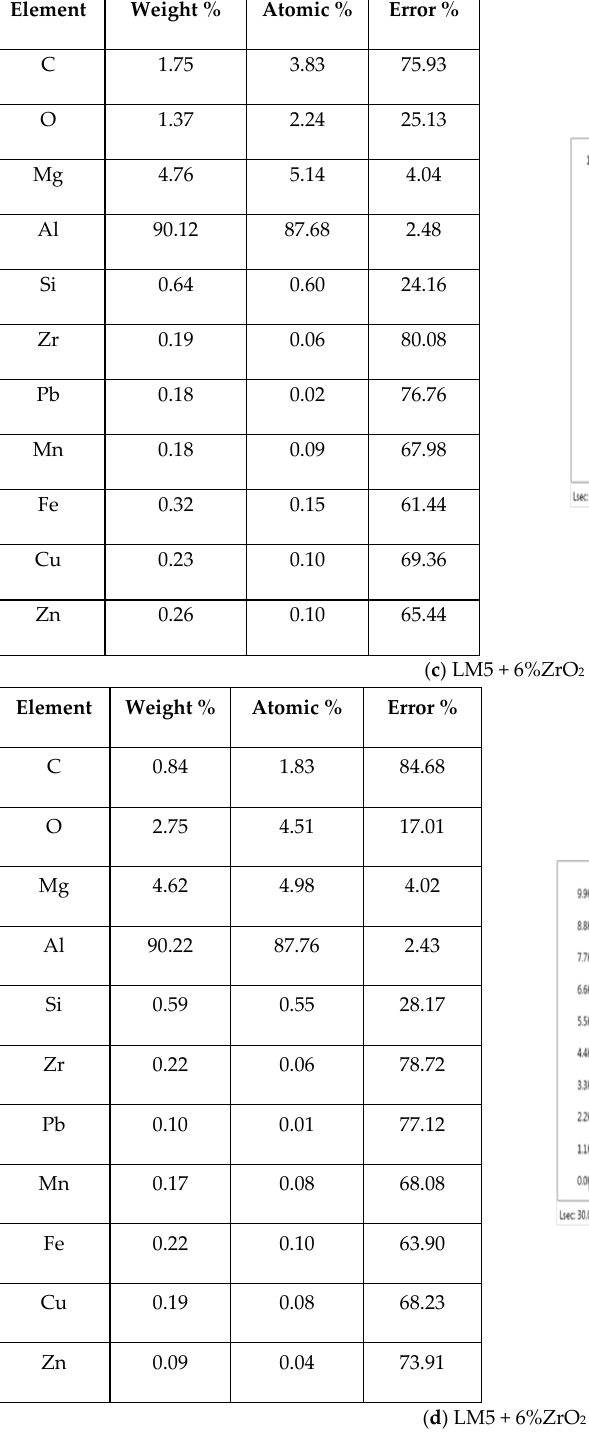
Figure 7. EDAX images of hybrid composites.